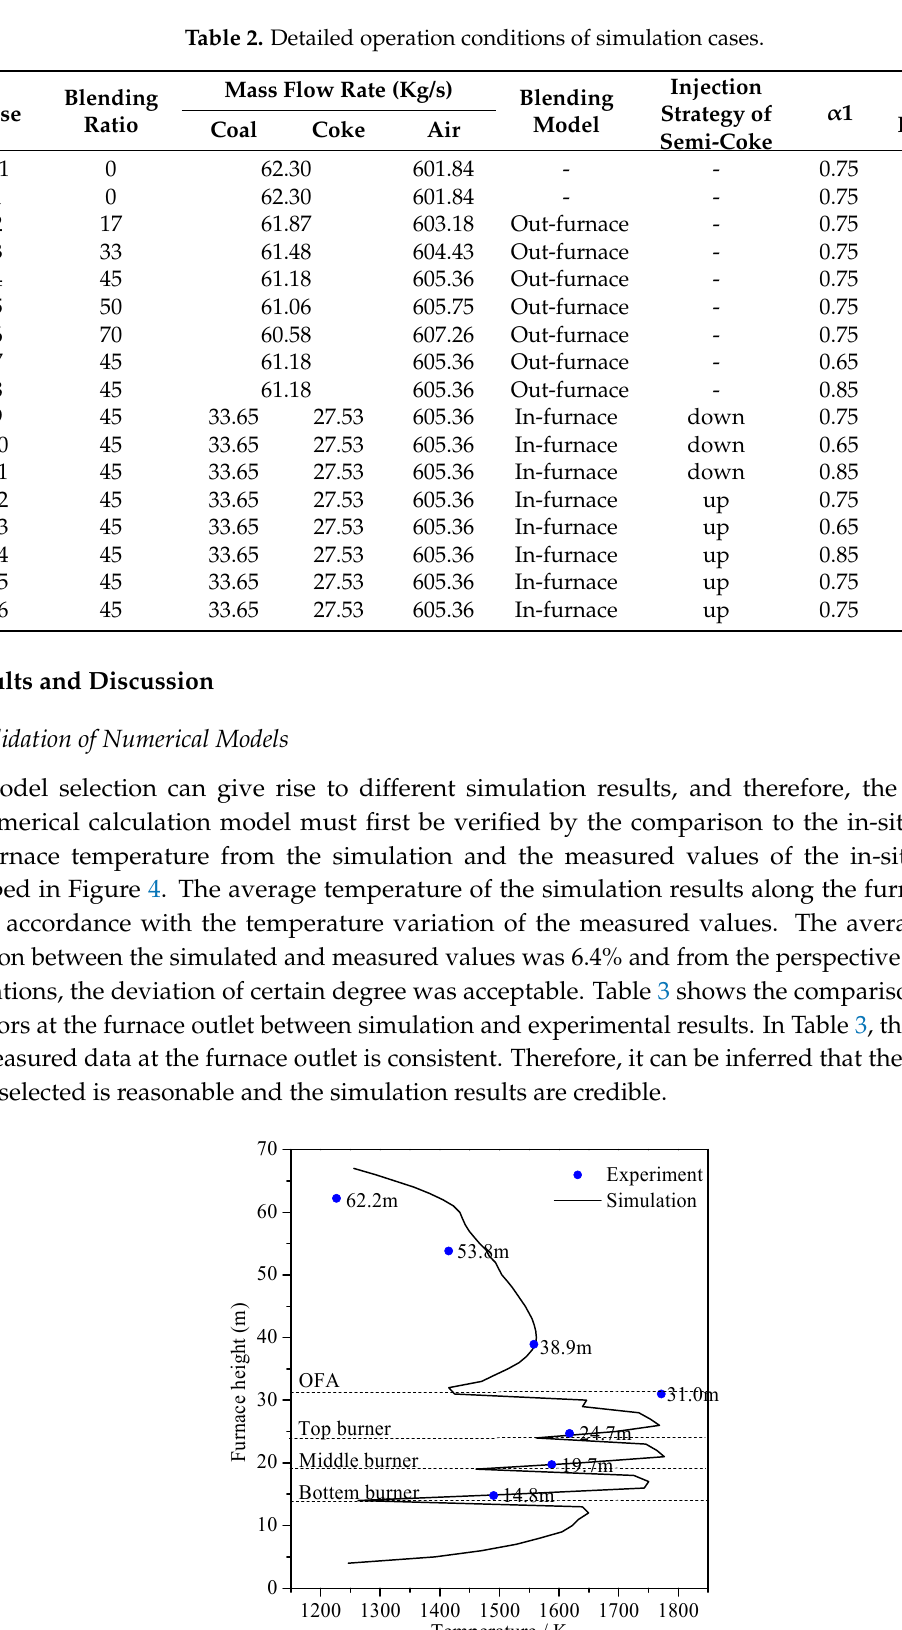
Table 2. Detailed operation conditions of simulation cases.